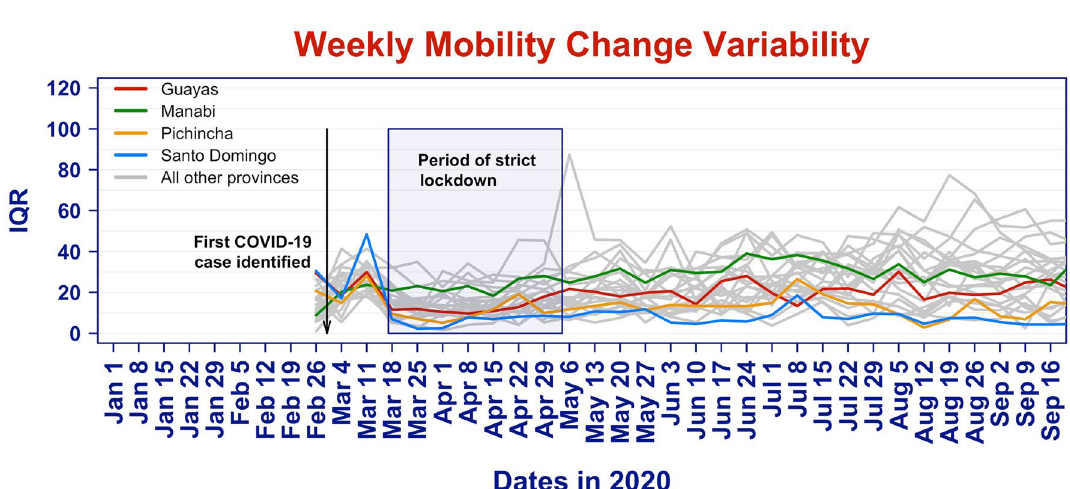
Figure 2. Time series of relative median mobility change for each province.